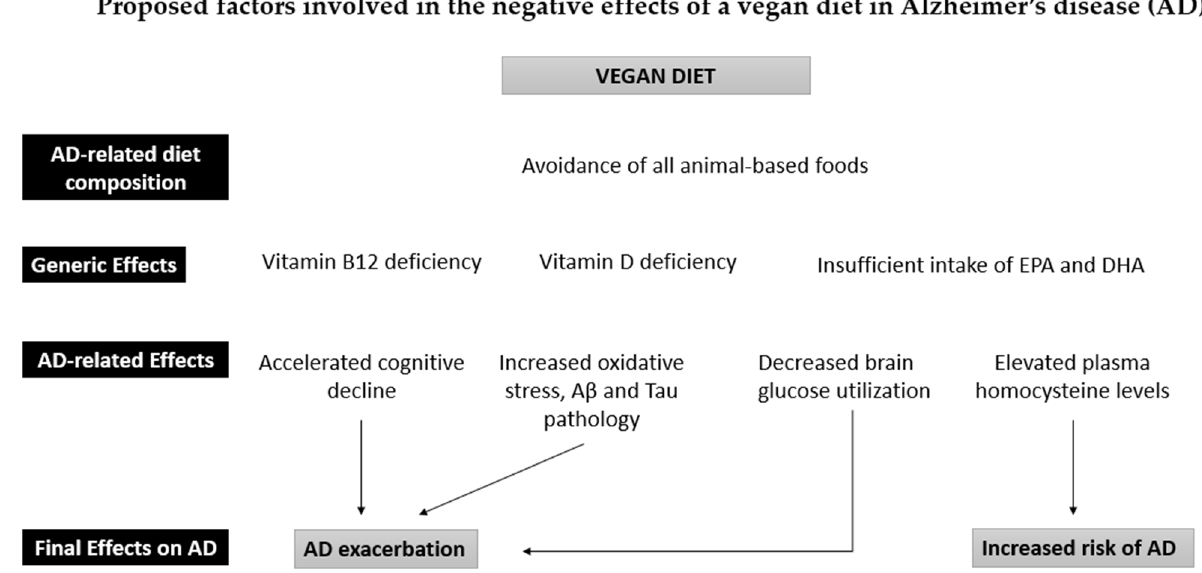
Figure 2. Proposed factors involved in the negative effects of a vegan diet in Alzheimer’s disease (AD). A vegan diet can easily lead to a deficiency in vitamins B12 and D if unsupplemented. Vitamin B12 deficiency accelerates cognitive decline, while a lack of vitamin D increases oxidative stress and A β and tau pathology. An insufficient intake of eicosapentaenoic acid (EPA) and docosahexaenoic acid (DHA), on the other hand, reduces brain glucose utilization. These factors can lead to the worsening of AD. Furthermore, these vitamin deficiencies lead to an increased risk of AD, both directly and indirectly (increase in plasma homocysteine levels).